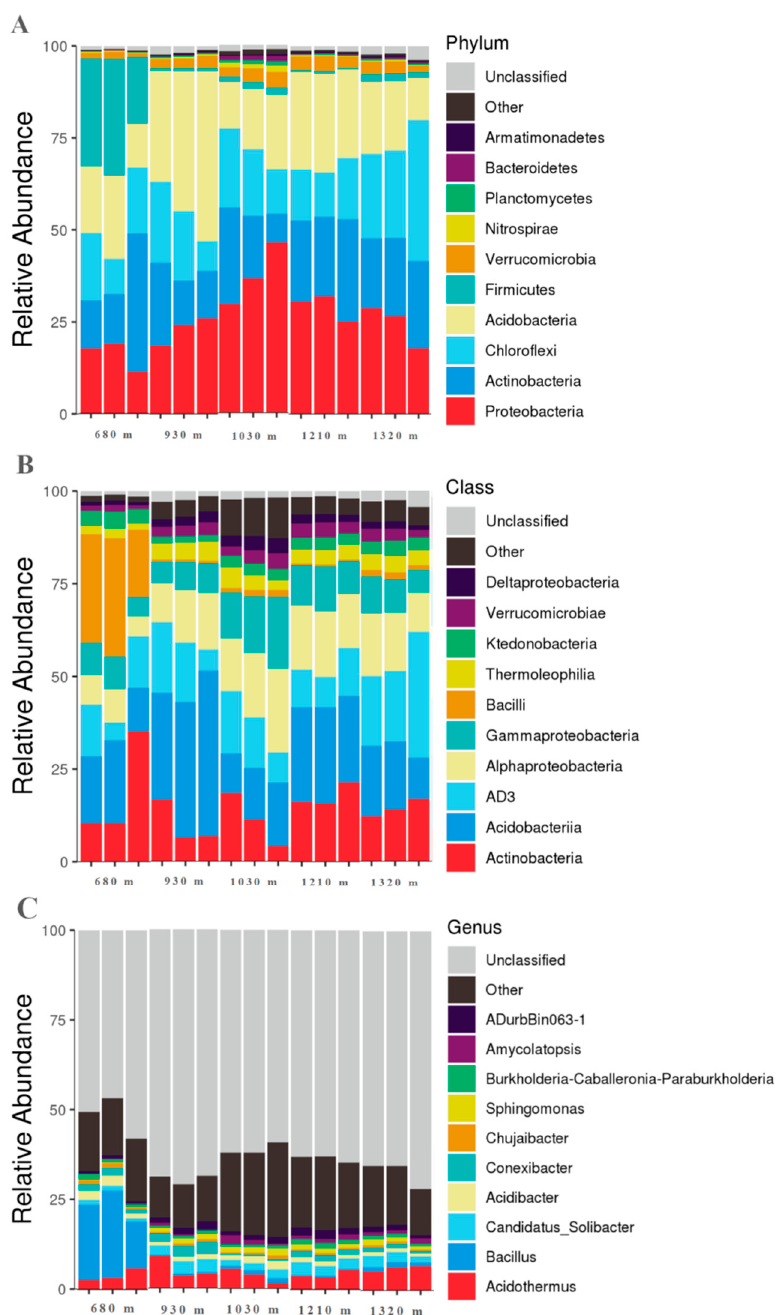
Figure 3. Bacterial community composition and structure in the C. arabica rhizospheric soil samples at different altitudes. ( A ) Top 10 bacterial phyla. ( B ) Top 10 bacterial classes. ( C ) Top ten bacterial genera. Relative abundance was calculated as the percentage of the total effective bacterial sequences in a sample. Classifications were based on the SILVA database. Phyla, classes, and genera that were not included in the top 10 in both libraries were classified as ‘Other.’ Data are presented for the rhizospheric soil samples collected at altitudes of 680, 930, 1030, 1210, and 1320 m. At the phylum level, Ascomycota was the most dominant phylum in the fungal community, accounting for 89.50% of all fungal phyla (Figure 4A). The alterations in the relative abundance of Ascomycota produced a valley curve. More specifically, the